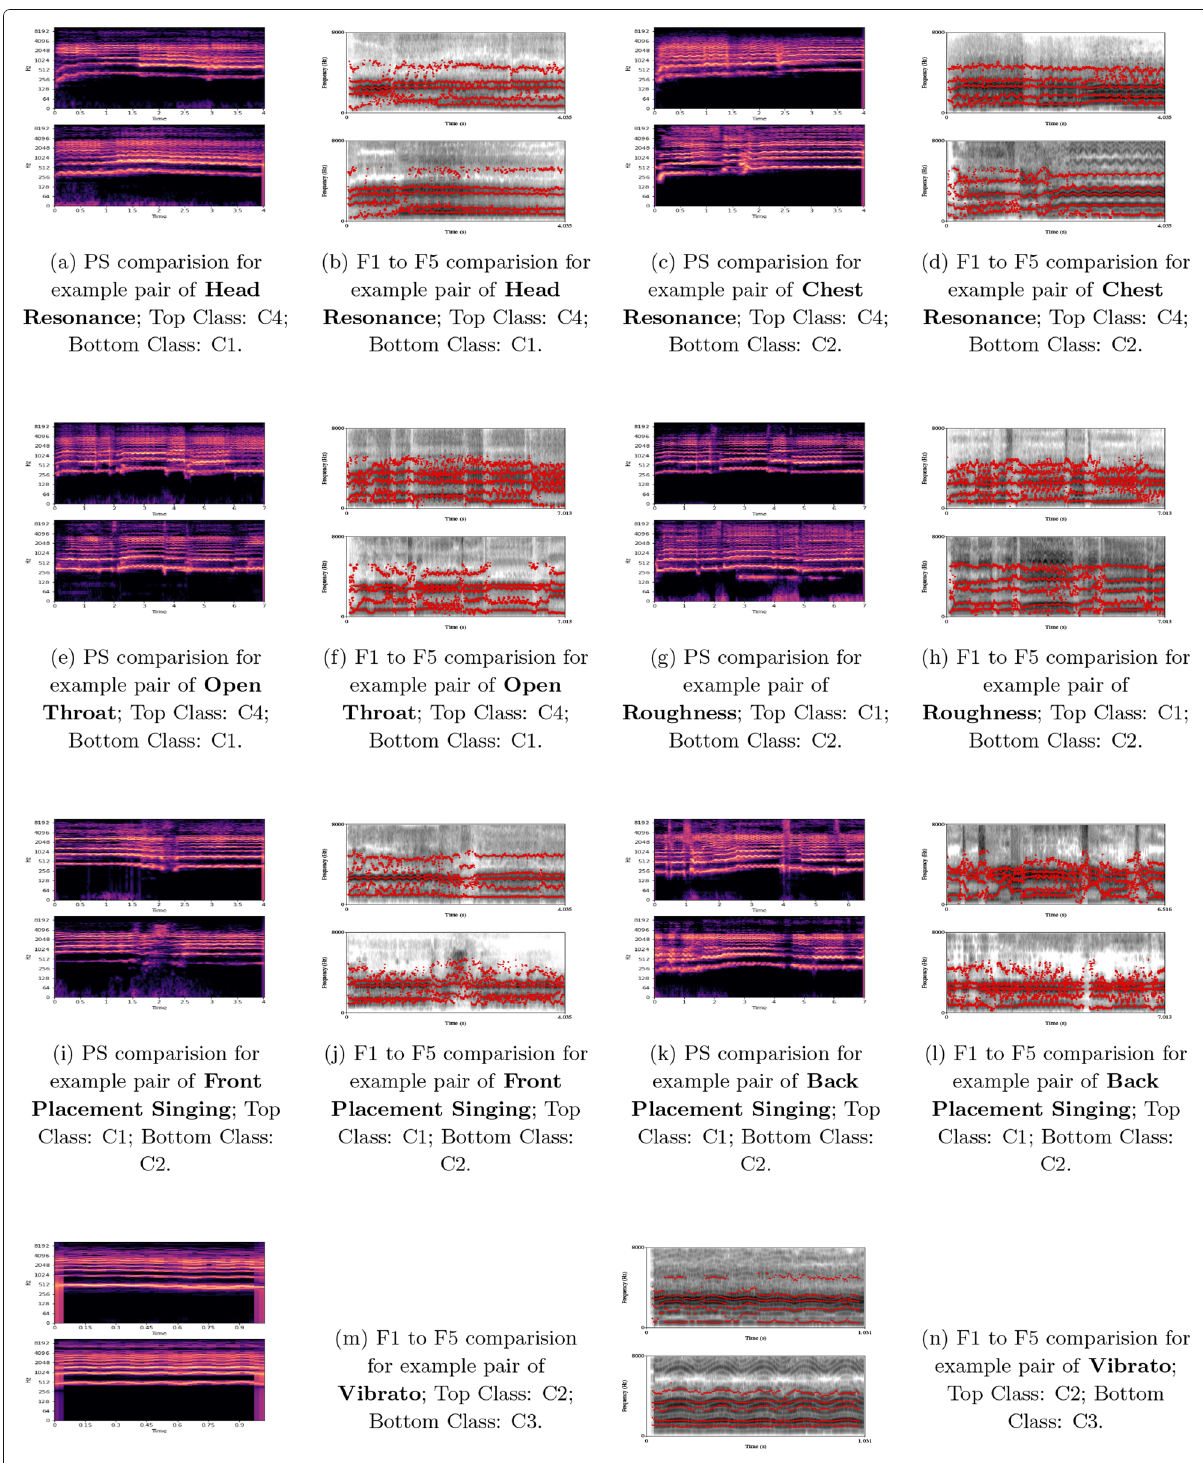
Fig. 2 Visual comparison of example pairs of paralinguistic singing attributes. PS, wide-band power spectrogram; F#, Tte corresponding formants depicted on the narrow-band